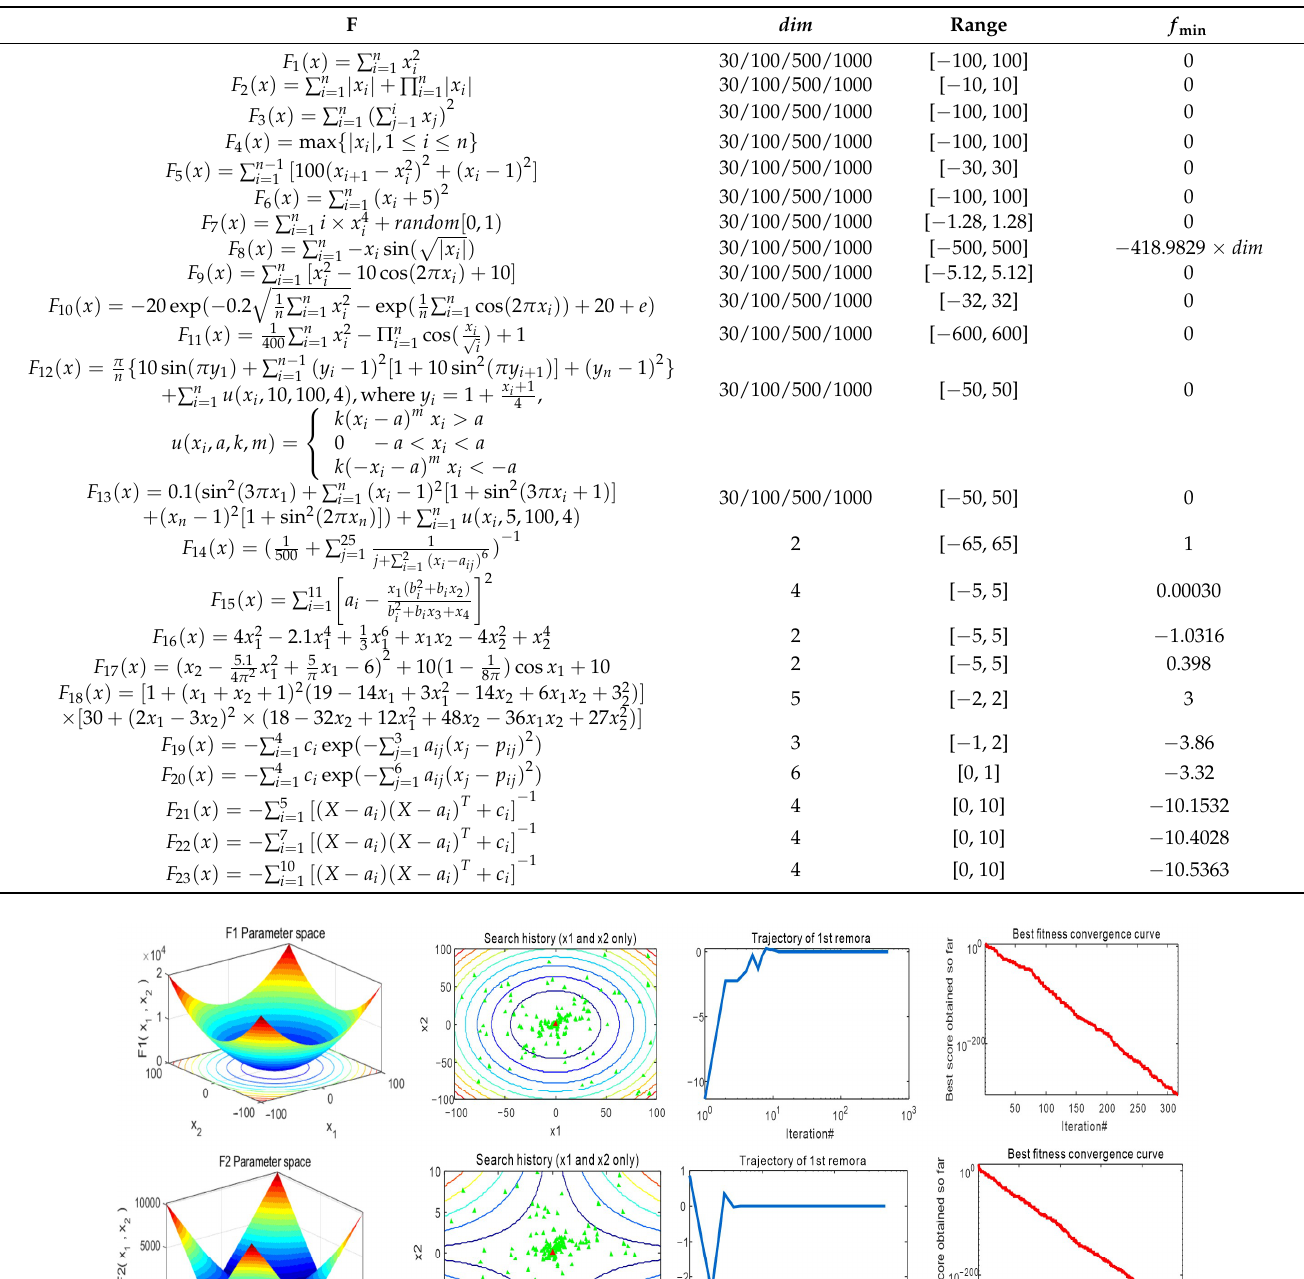
Table 2. Details of 23 standard benchmark functions ( dim indicates the dimension).